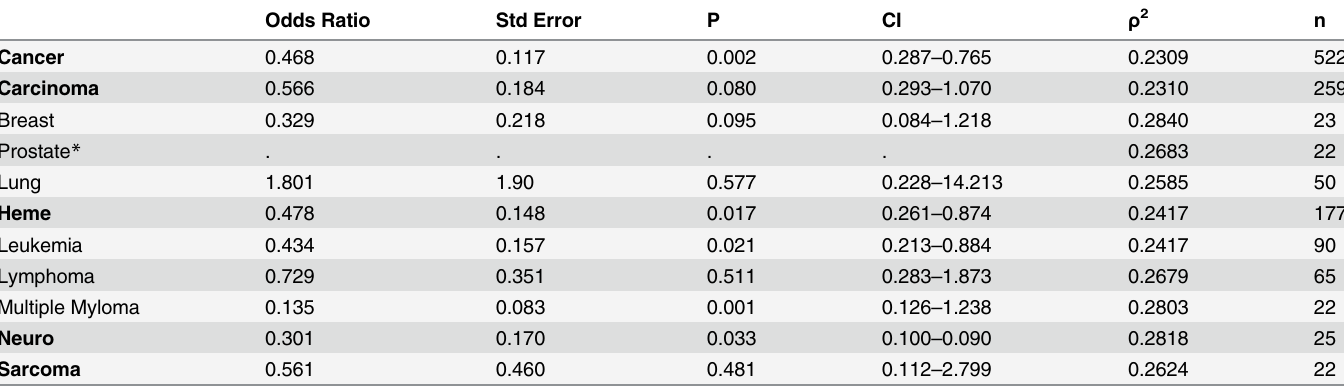
Table 2. Aortic atherosclerosis, statistical results.